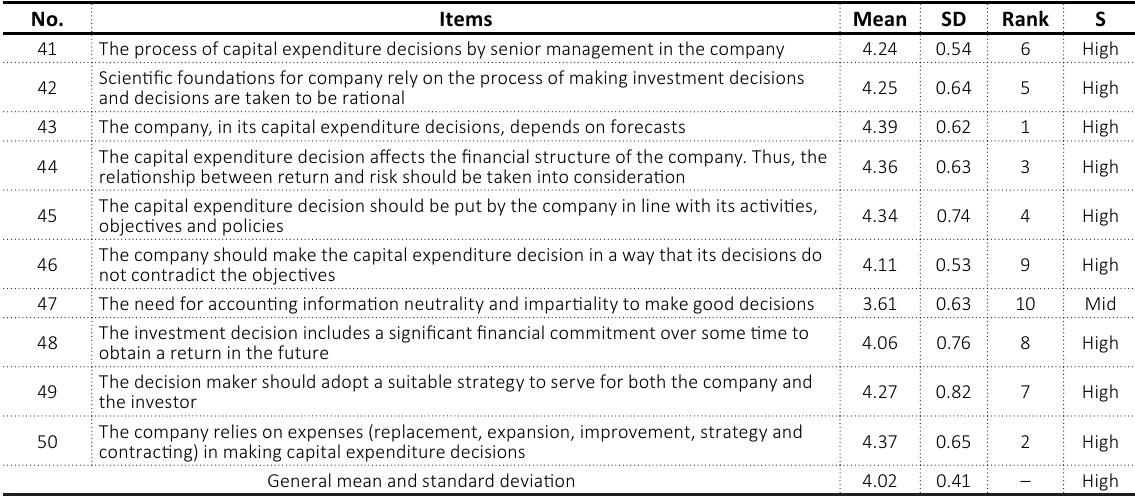
Table 16. Items related to the main hypothesis